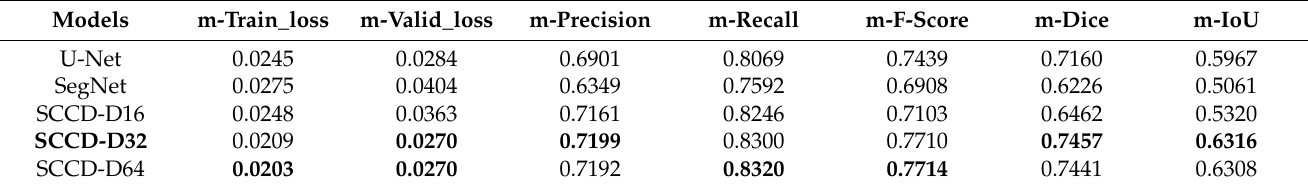
Table 2. Results of 5-fold cross-validation. The best average scores are in